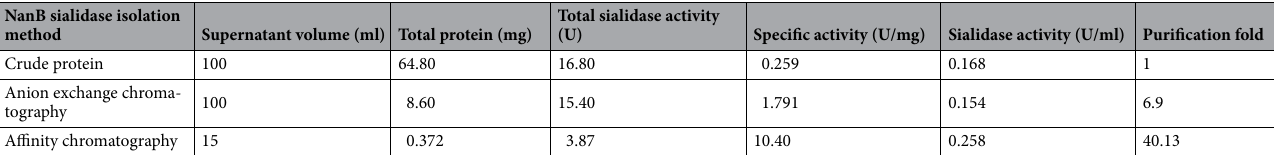
Table 6. Results of purification of NanB sialidase by anion exchange chromatography and affinity